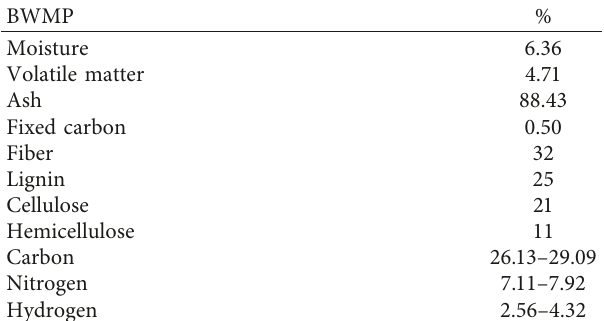
Table 1: Physicochemical analysis of sorbent materials.